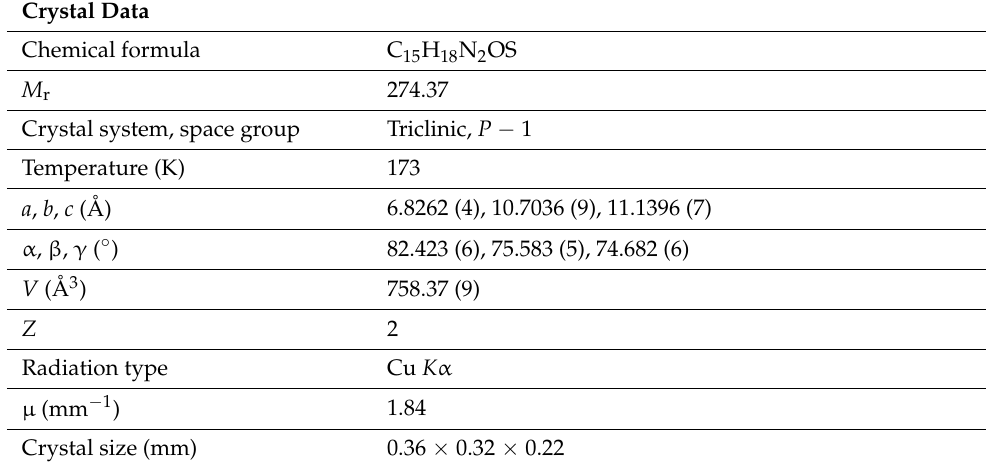
Table 3. Extensive details of X-ray